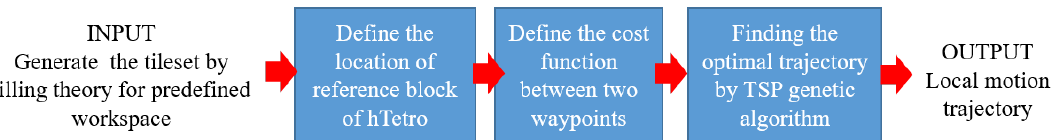
Figure 6. Block diagram of proposed local motion planing strategy for tiling-based complete path planning. TSP: traveling salesman problem.